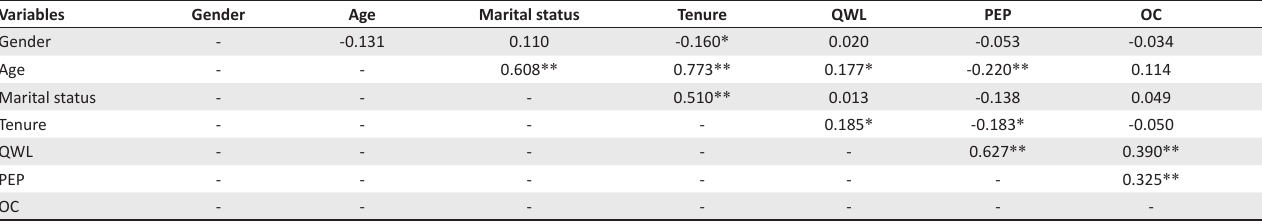
TABLE 3: Correlation among study variables.